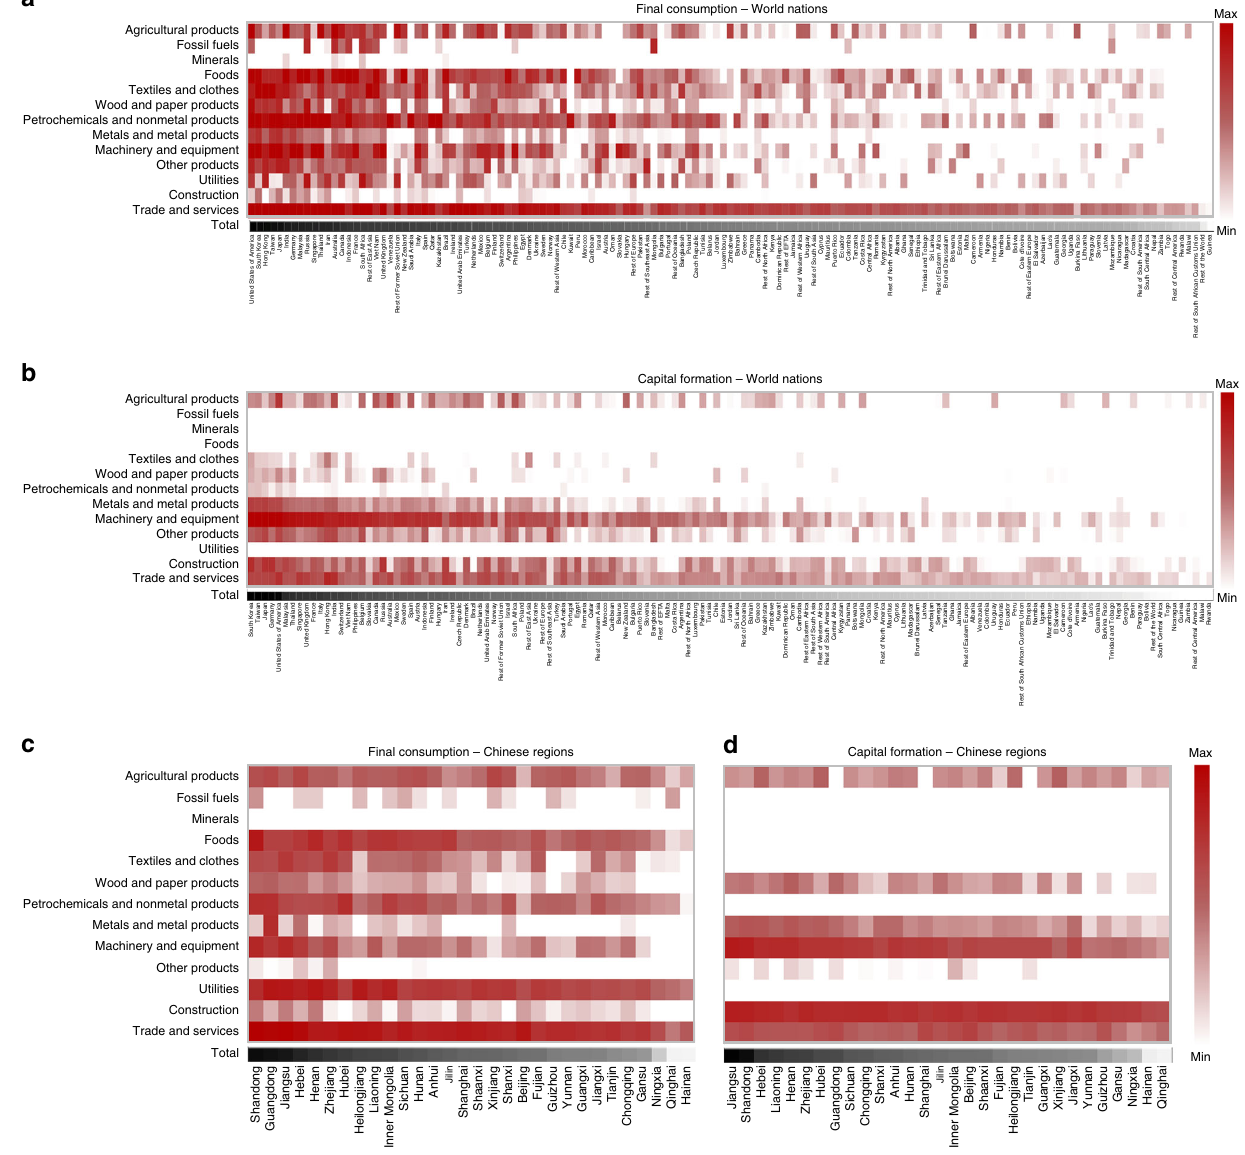
Fig. 4 Global CO 2 emissions induced by a unit of fi nal consumption or capital formation in China. Each grid in a , c indicates the global CO 2 emissions induced by China ’ s one unit of fi nal consumption of products from each sector of nations other than China ( a ) and Chinese regions ( c ). Each grid in b , d indicates the global CO 2 emissions induced by China ’ s one unit of capital formation of products from each sector of nations other than China ( b ) and Chinese regions ( d ). The black/white bars at the bottom show the total global CO 2 emissions caused by China ’ s one unit of fi nal consumption or capital formation of nations or Chinese regions. A darker colour indicates larger global CO 2 emissions. Results in more sectoral detail are shown in Supplementary Fig.